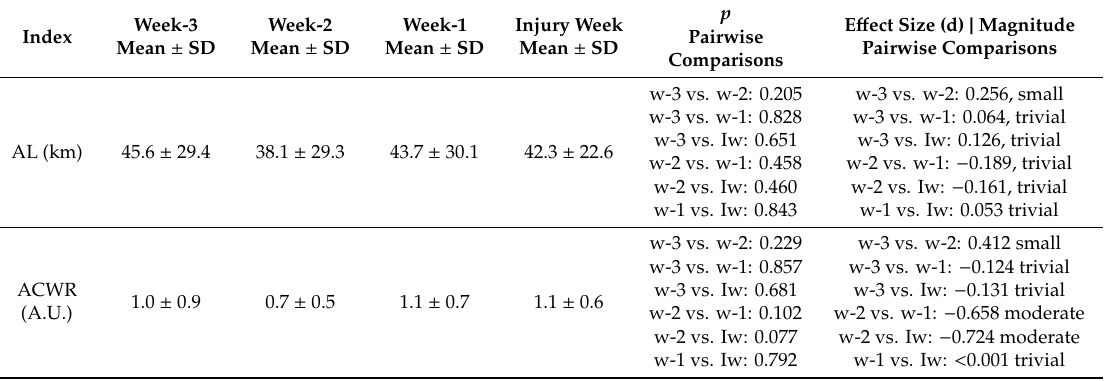
E ff ect Size (d) | Magnitude Pairwise